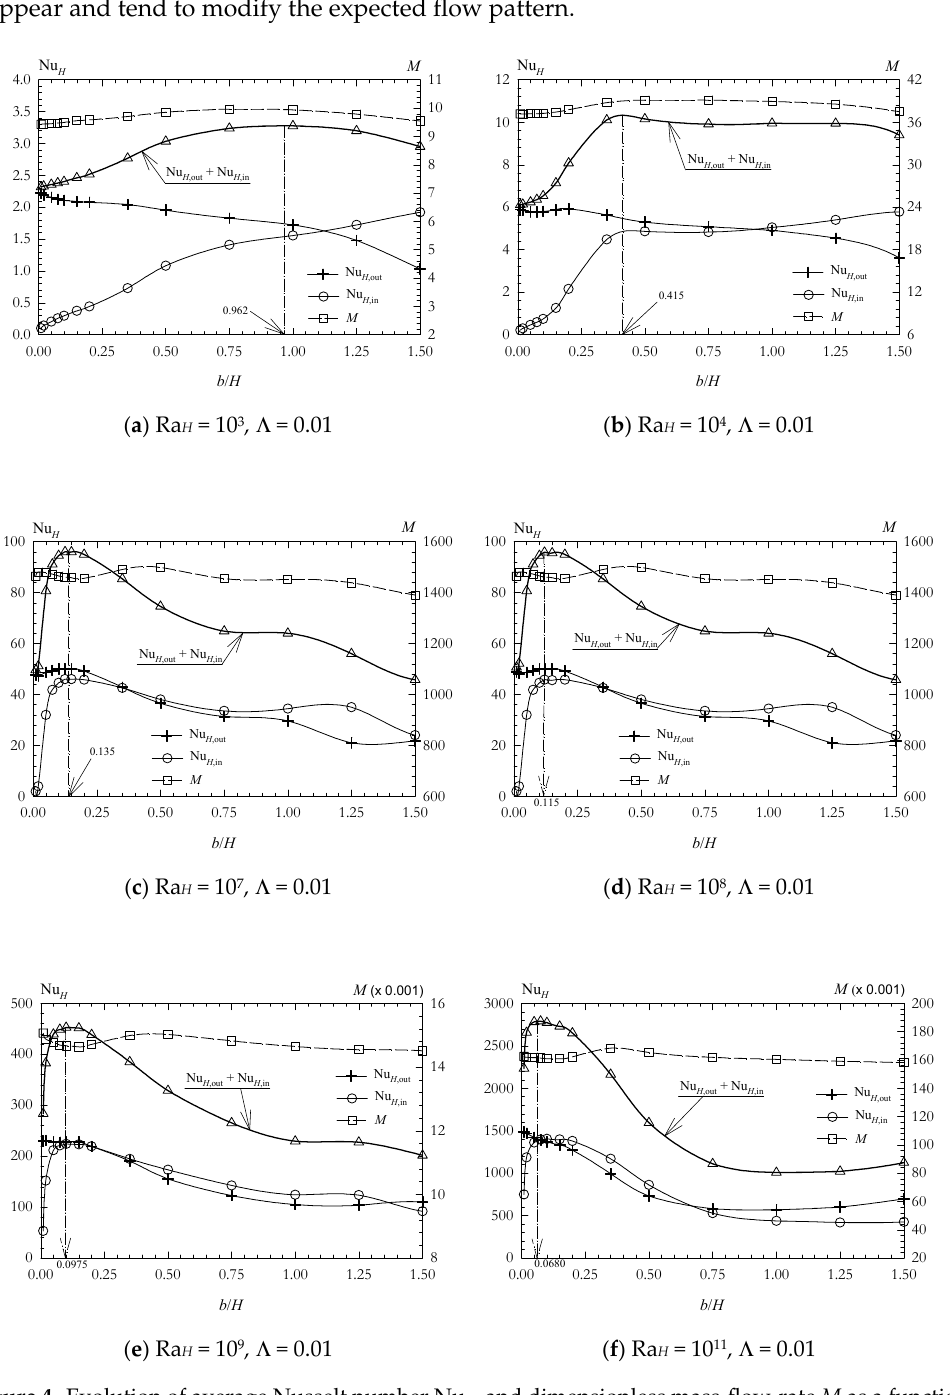
Figure 4. Evolution of average Nusselt number Nu H and dimensionless mass-flow-rate M as a function of aspect ratio b / H , for different values of Ra H , with an indication of the thermally optimal points. Configuration is given in Figure 1b. Heating parameter Λ = 0.01. Note that in (e) and (f), values of M are divided by 10 3 .